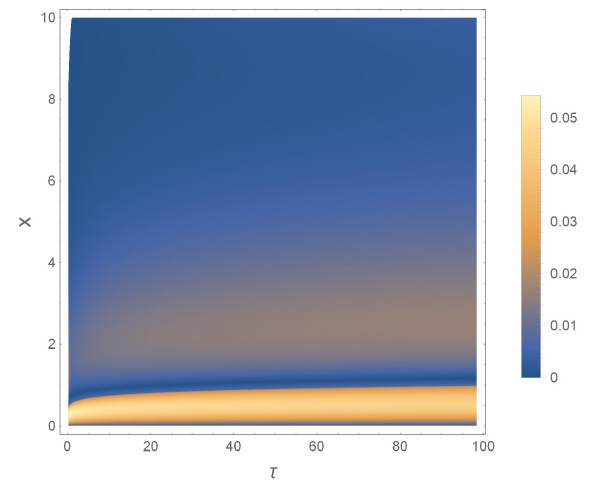
Figure 14. Absolute error for α = 0.25, λ 1 = 1, λ 2 = 2, κ 1 = 1, κ 2 =